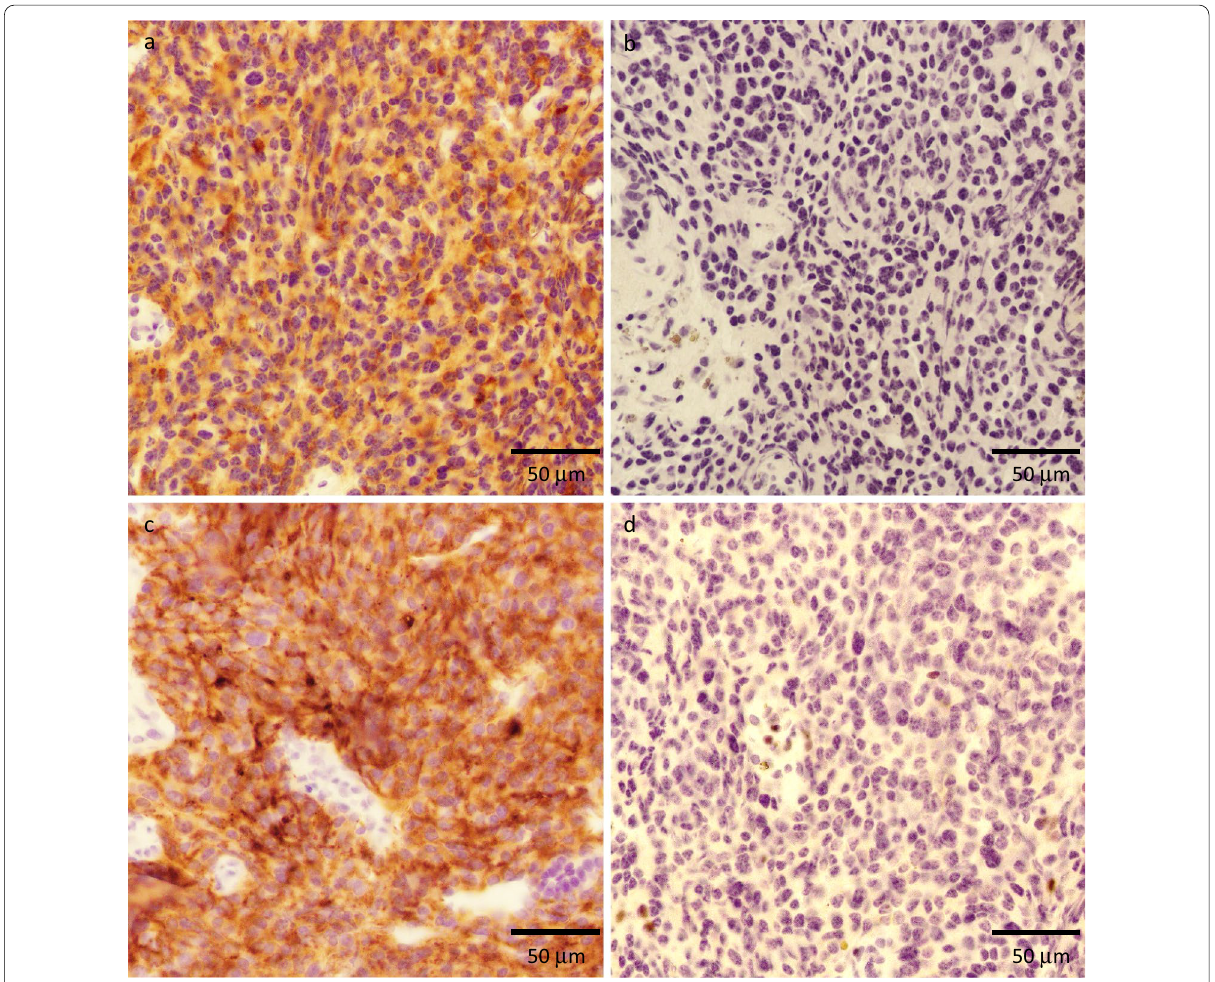
Fig. 6 Immunohistochemical findings of the breast tumors. a Calcitonin was positive in the tumor (1). b GCDFP-15 was negative in the tumor (1). c CEA was positive in the tumor (2). d GATA3 was negative in the tumor